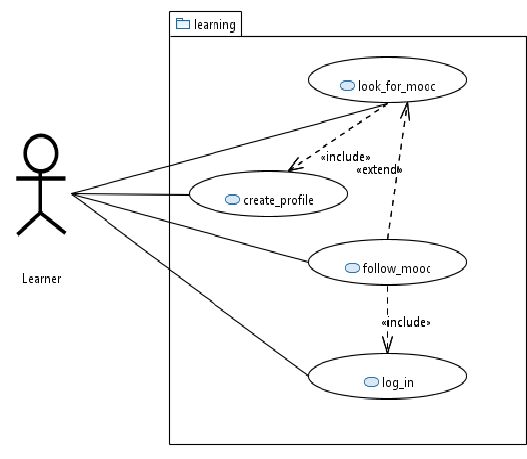
Fig. 1. Learner use case diagram